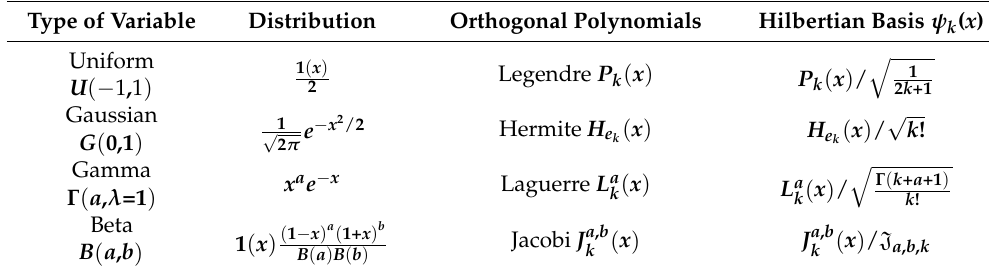
Table 2. List of classic univariate polynomial families